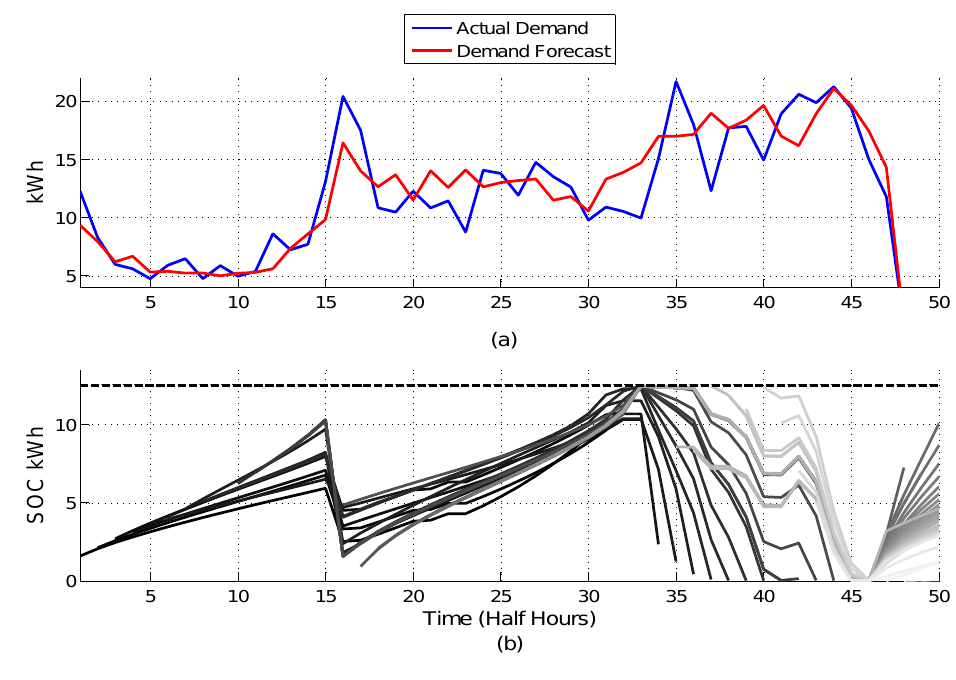
Figure 5. ( a ) The forecasted and actual demand profiles; ( b ) the evolution of the state of charge (SOC) across the horizon.